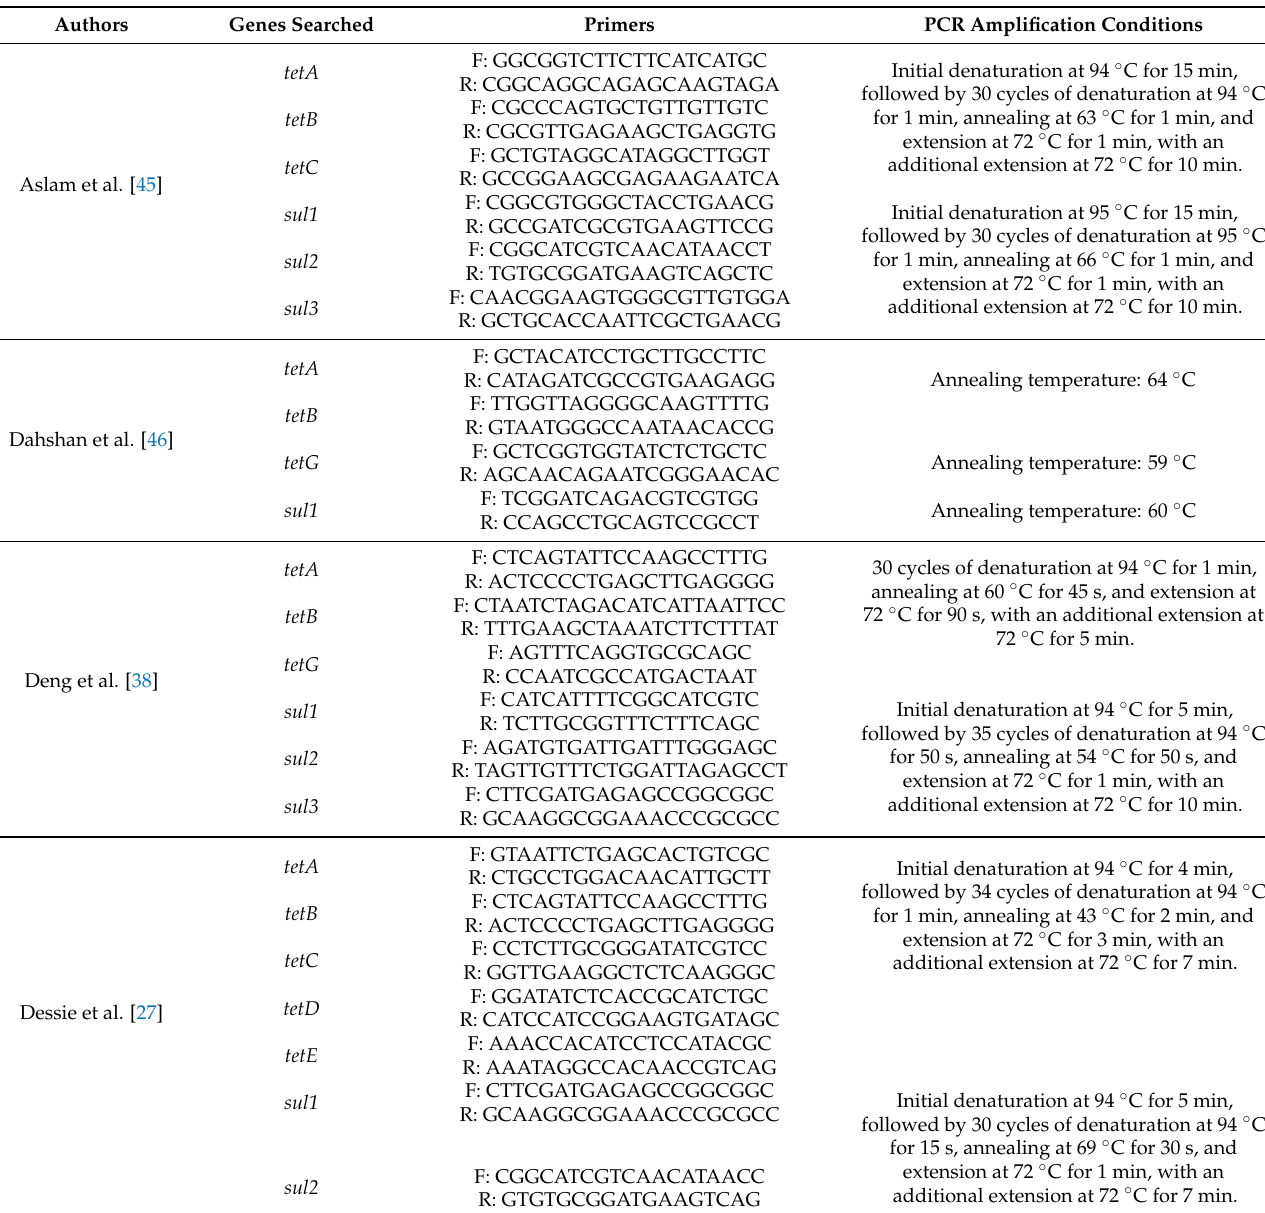
Table 4. Primer sequences and PCR conditions used for the amplification of tetracycline and sulfonamide resistance genes.